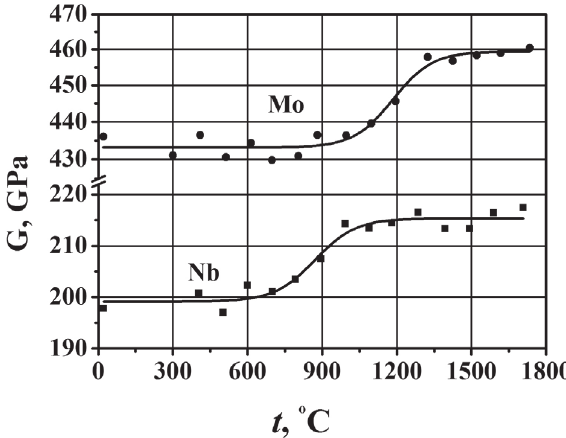
Figure 6. Dependence of the shear modulus of the irradiated ni- obium and molybdenum samples on the isochronous annealing